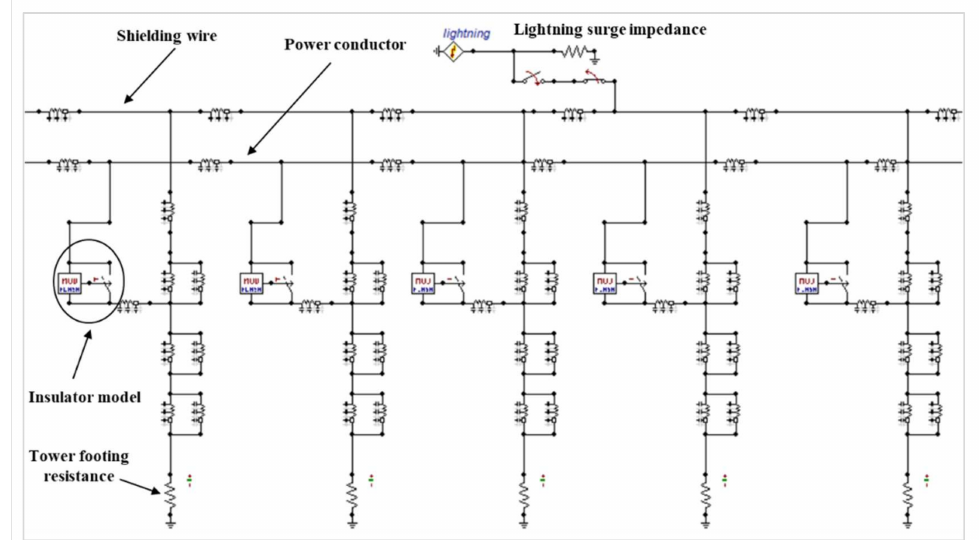
Figure 7. DC transmission line model in